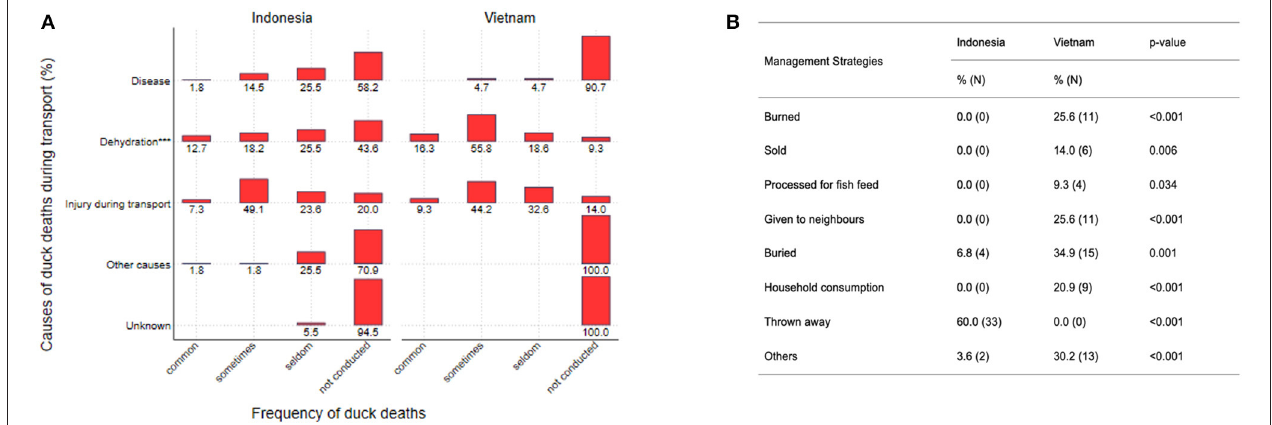
FIGURE 2 | (A) Causes of death ducks during transport in Indonesia ( N = 55) and Vietnam ( N = 43) with percent of respondents by frequency category. P -values for comparisons between countries for each category are presented as follows: *** for P ≤ 0.001. (B) Disposal of ducks that died during transport in Indonesia and Vietnam.